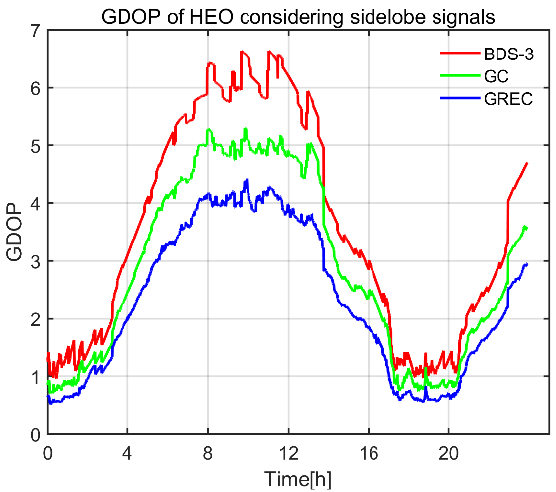
Figure 13. GDOP of HEO spacecraft. Visible satellites and GDOP of lunar probe with thresholds of 20 and 15 dB-Hz are shown in Figures 14 and 15,